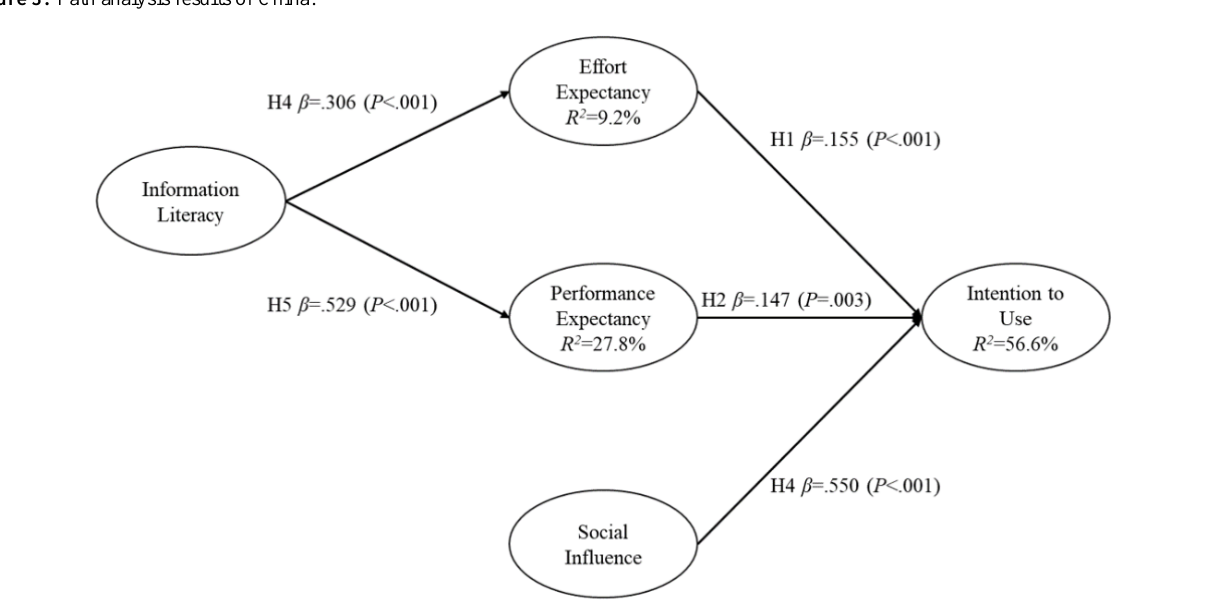
Figure 3. Path analysis results of